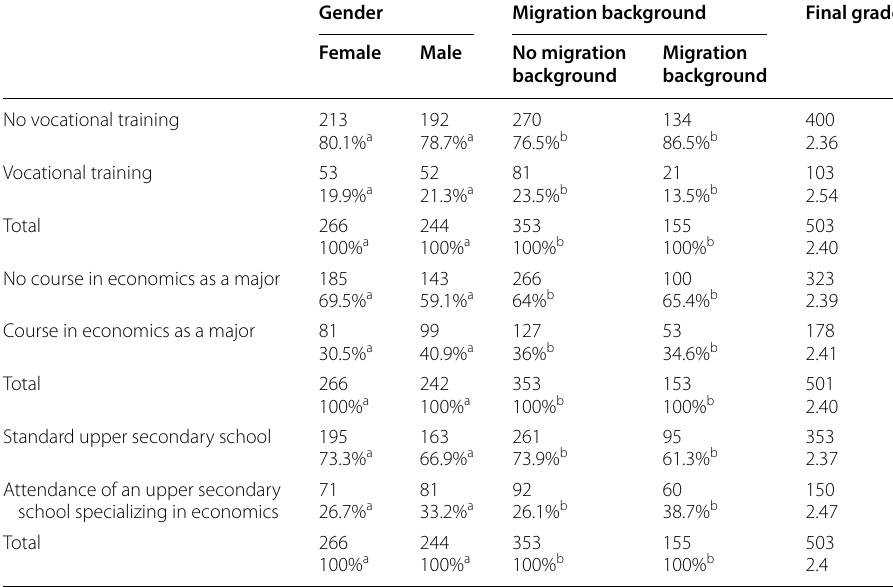
Table 2 Cross-classification of learning opportunities and